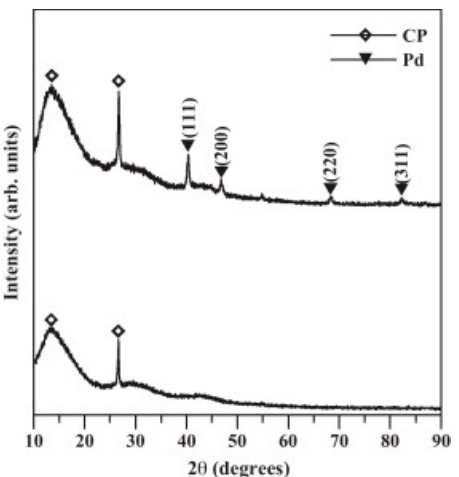
Figure 4. X-ray diffractograms of ( a ) pure carbon paper and ( b ) Pd deposited over GO–CP substrate. Reprinted with permission from [56].